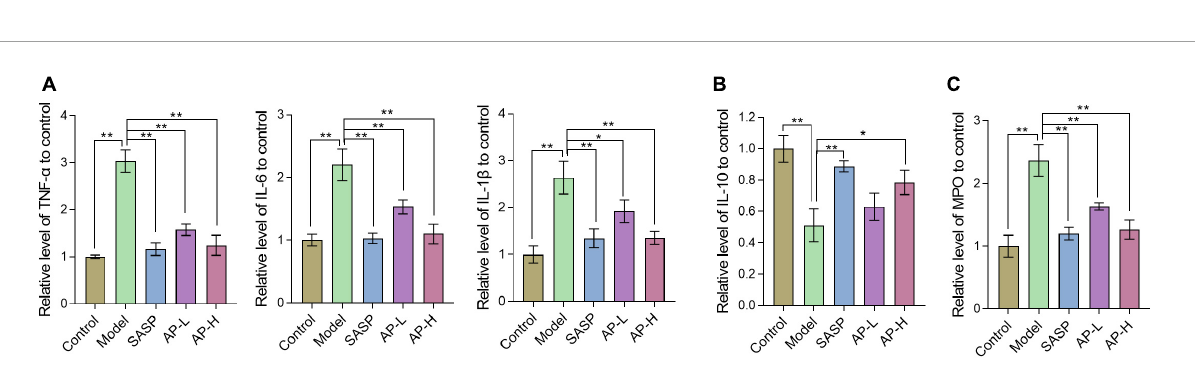
FIGURE3 Apigenin treatment altered the cytokine expression in colitis mice. (A) Expression levels of inflammatory cytokines TNF- α , IL-6, and IL-1 β in colon tissues. (B) Expression levels of inflammatory cytokines IL-10 in colon tissues. (C) Expression levels of MPO in colon tissues. * P < 0.05, ** P <